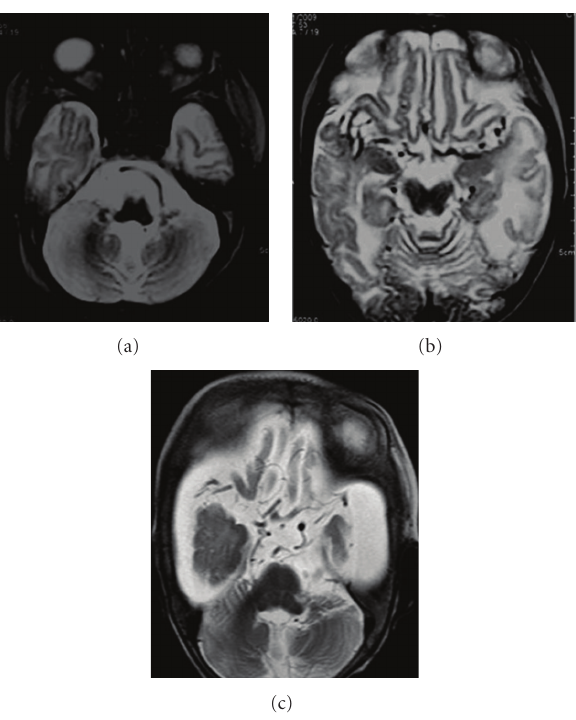
Figure 3: Atrophy of the cerebellum with prominence of cerebellar folia. Asymmetric cortical and subcortical hyperintensities on the axial T2WI predominantly in bilateral temporoparietal regions with involvement of the insular